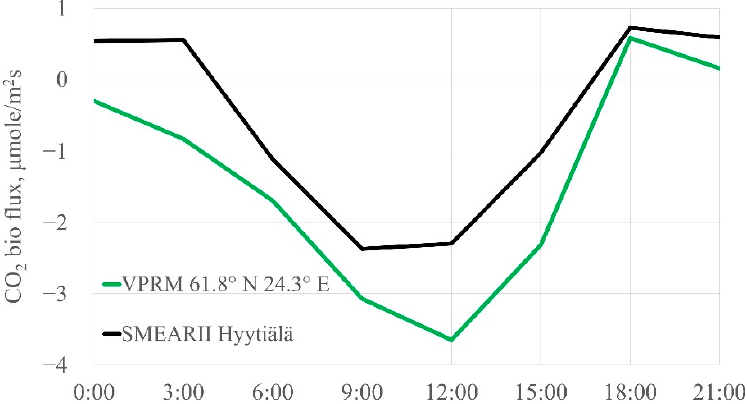
Figure 4. Averaged diurnal cycle of CO 2 biogenic fluxes according to VPRM and Hyytiälä observa- tions for March–April 2019.